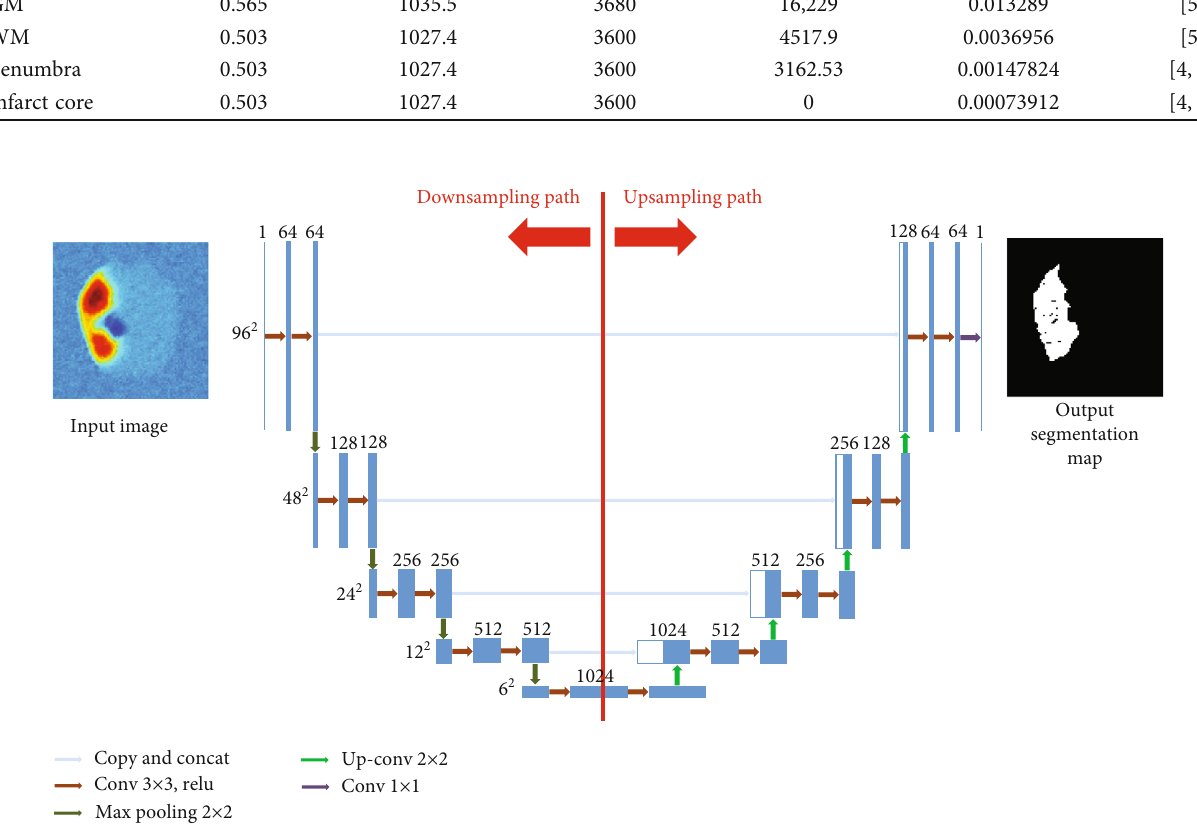
Figure 1: A schematic of U-Net architecture trained on thermal images. The input of the network is a normalized thermal 2D image, and the output is the segmentation map using Dice coe ffi cient as a loss function with sigmoid activation function. The architecture includes a downsampling path and an upsampling path, with concatenation between the corresponding